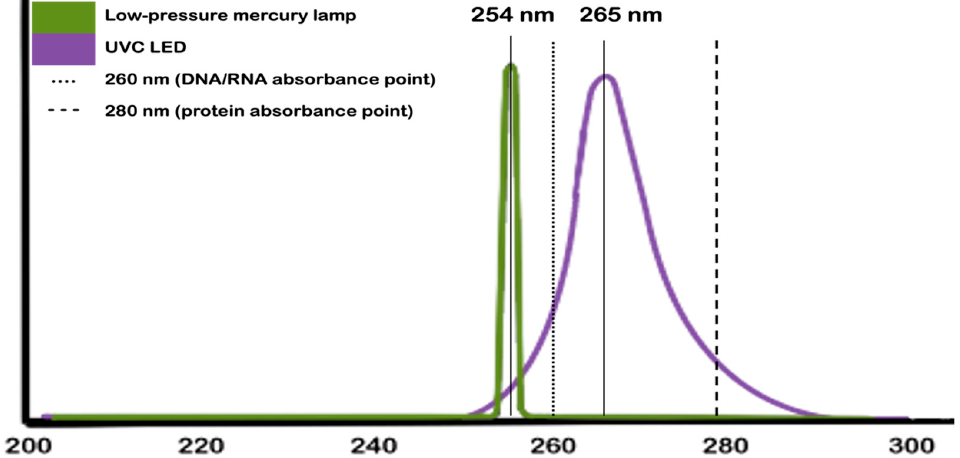
Figure 1. Wavelength peaks according to the UVC sources. Note: We abstained from providing the curve for medium-pressure lamps because they overlap with one of the UVC LEDs. For technical parameters about UVC traditional sources and LEDs, we suggest moving to Section 4.